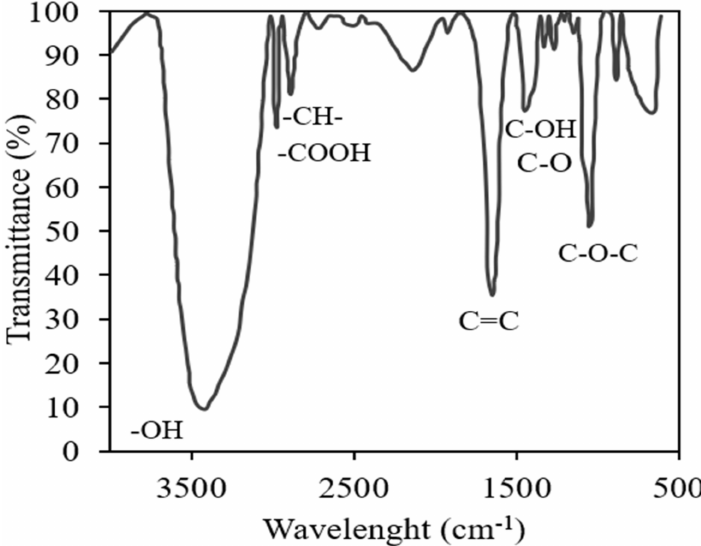
Figure 4. FTIR spectra sample of AGC extracted from soapnut.